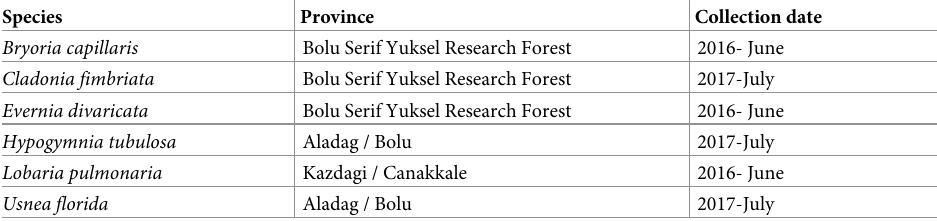
Table 1. Lichen species, location (province) and collection date.